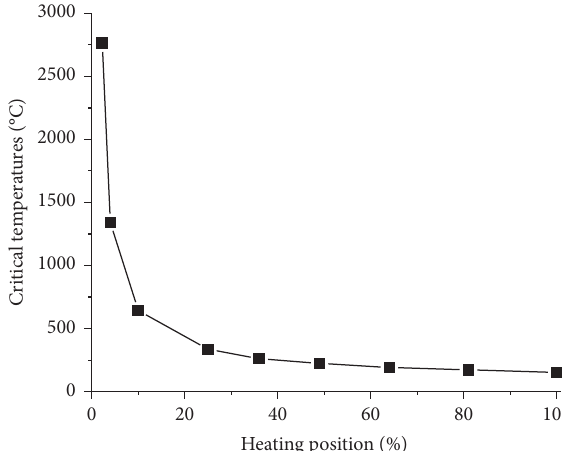
Figure 7: Critical temperatures of composite laminated plates with different heating areas.